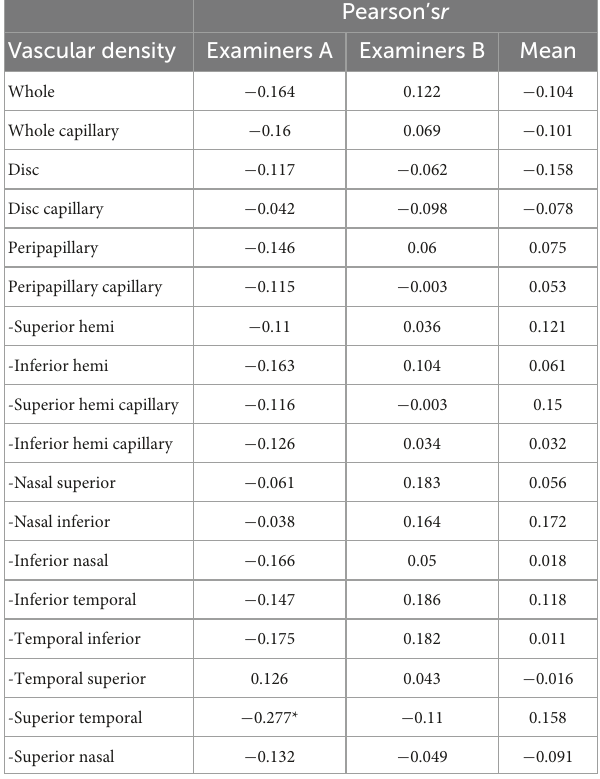
TABLE 4 Effect of axial length on the repeatability measurement of the papillary and peripapillary vascular density.